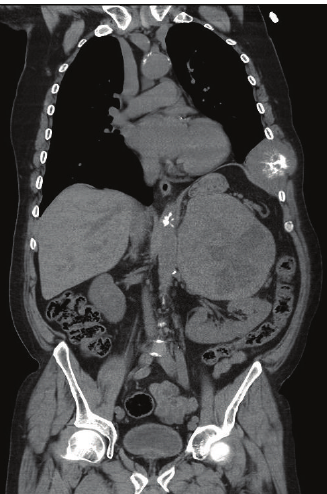
Figure 2: 127 × 143 × 144 mm (RL × AP × KK) mass in the left adrenal surgical space, pushing down the left kidney on CT and the rib metastasis.